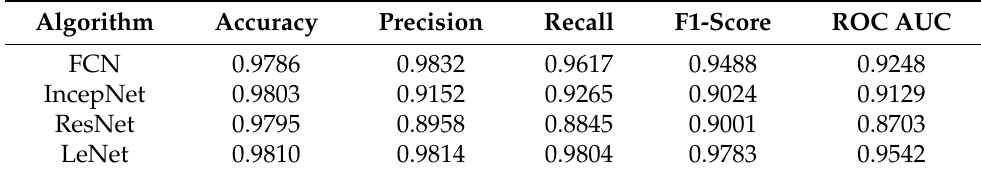
Table 6. DTL models’ performance comparison